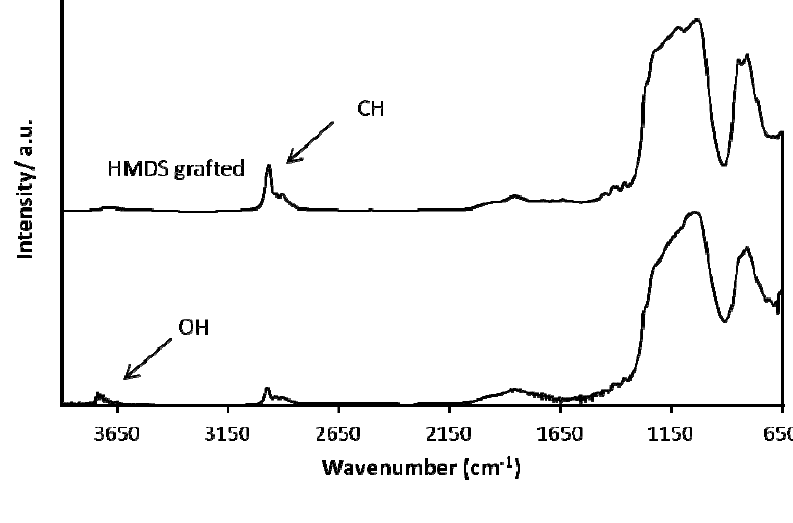
Figure 6. DRIFT spectrum of functionalized MCM-41 before and after hexamethyl disilazane (HMDS)